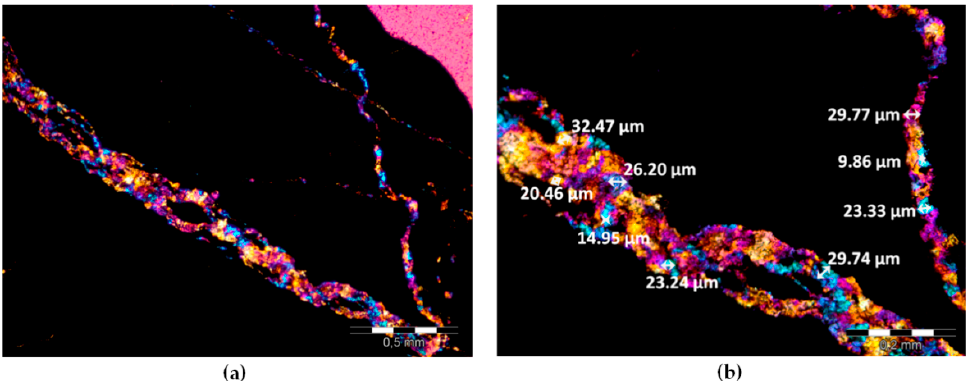
Figure 3. Hematite aggregate H1 with visible veins of microcrystalline quartz in XPL_G: ( a ) scale bar = 500 μ m; ( b ) scale bar = 100 μ